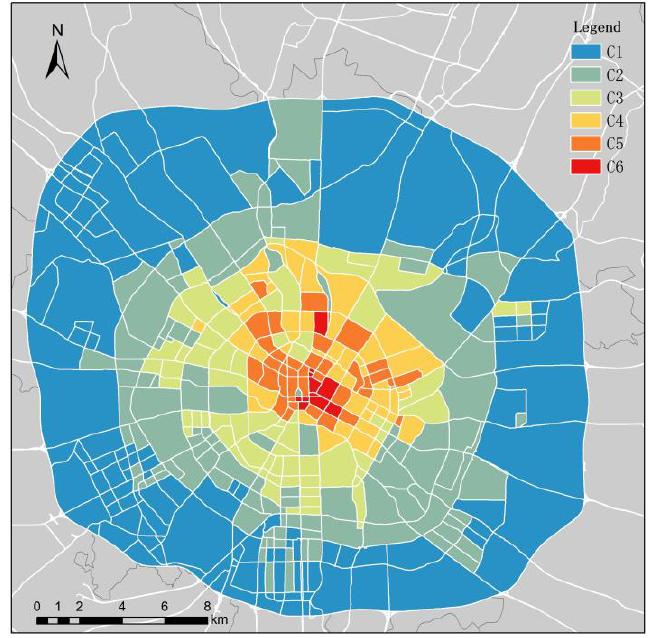
Figure 6. The results of K-medoids. Based on the trajectory time series data, the land is divided into six clusters (C1~C6), but the specific functions of each cluster are still unknown.